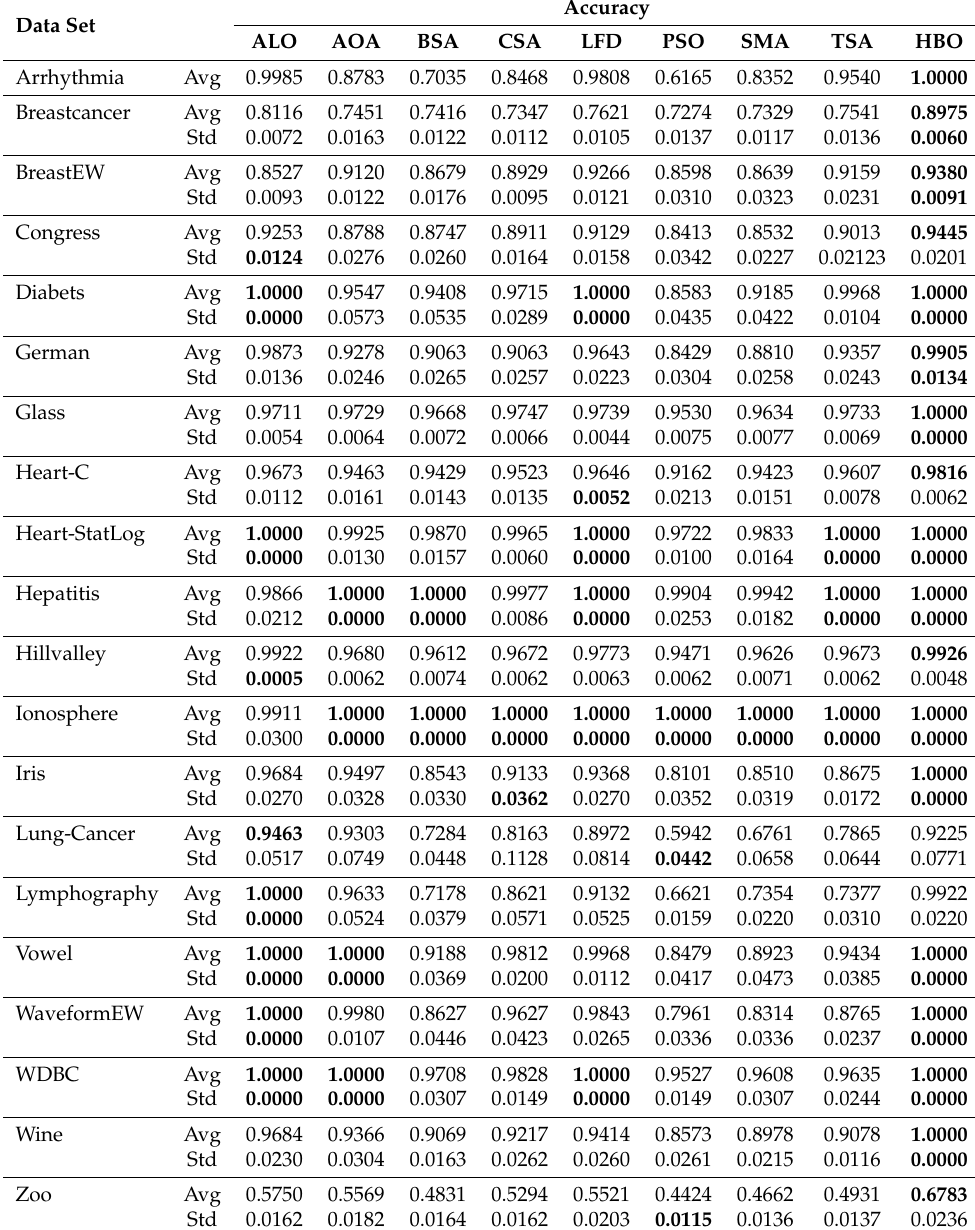
Table 5. The average Accuracy of B_HBO against other recent optimizers.